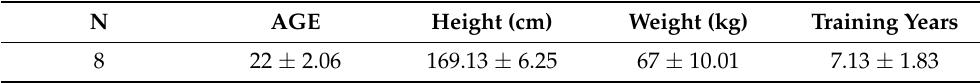
Table 1. Information on